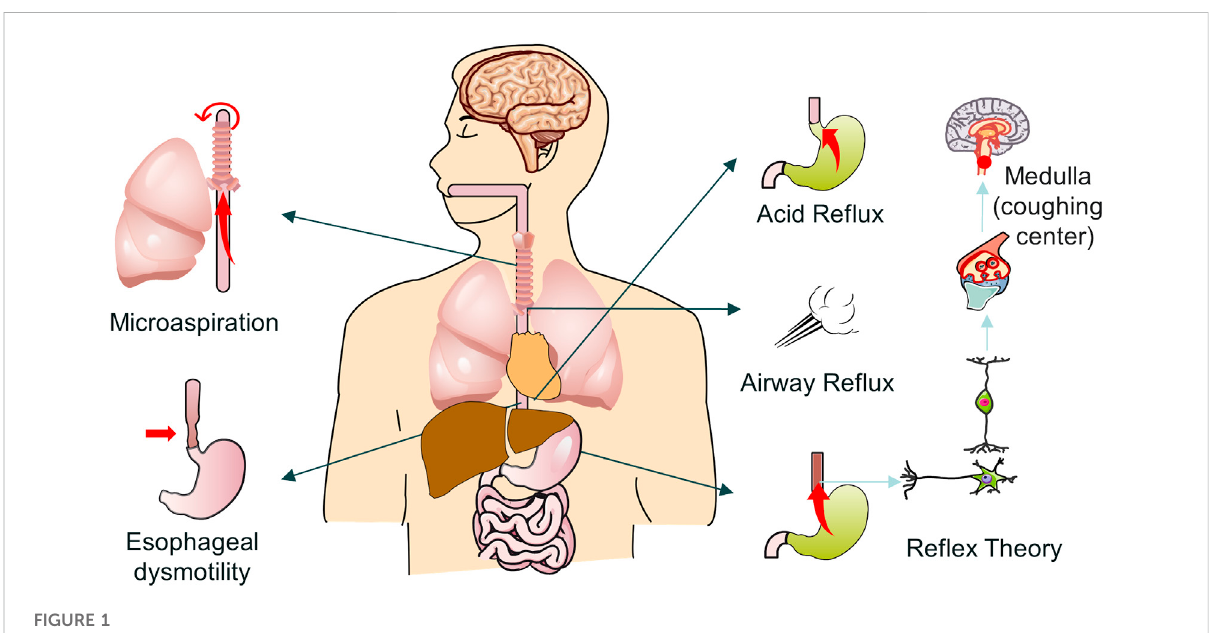
FIGURE 1 Possible mechanism of